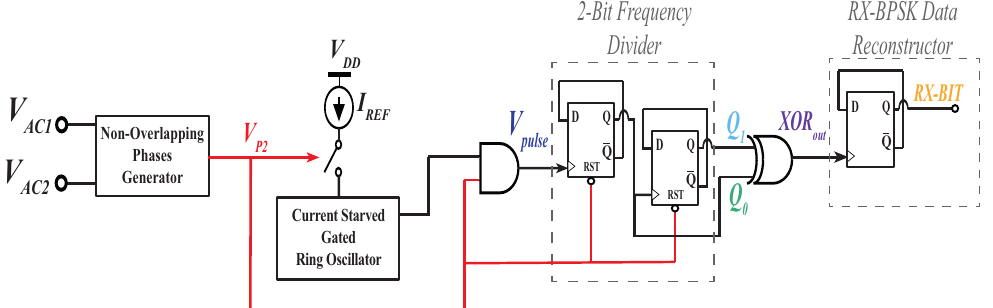
Figure 6. Block diagram of the proposed BPSK